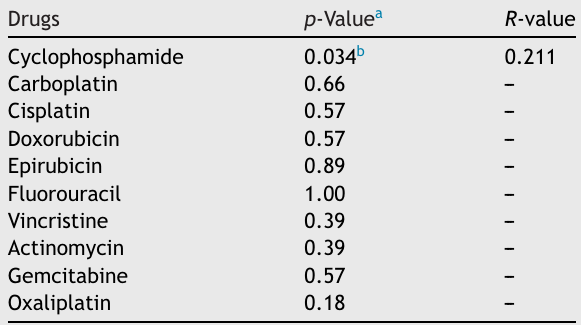
p -Value calculated for the correlation between drug used in chemotherapy vs. presence of hearing loss ( n =